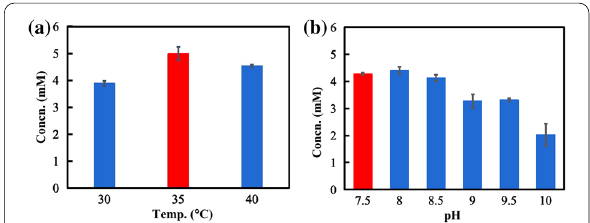
Fig. 1 Optimization of the temperature ( a ) and pH ( b ) of Module 2. Reaction conditions (0.5 mL): ( )‑Perillyl alcohol 10 mM, Lk ADH 0.2 − U/mL, [ Lk ADH]/[NOX]/[ATA‑117] 1/5/10, 0.2 mM NAD + , 0.1 mM = PLP, 50 mM 2‑pentanamine, potassium phosphate buffer (pH 7.5, 100 mM) or Tris–HCl buffer (pH 8–9, 100 mM) or Gly‑NaOH buffer (pH 9.5–10, 100 mM), 30 ℃ , 35 ℃ or 40 ℃ , 800 rpm, 12 h. Temp.: